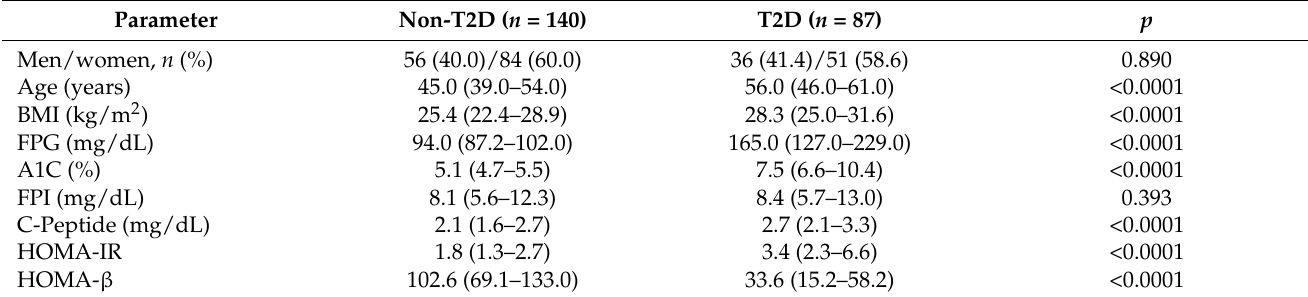
Table 1. Clinical characteristics of the study participants according to